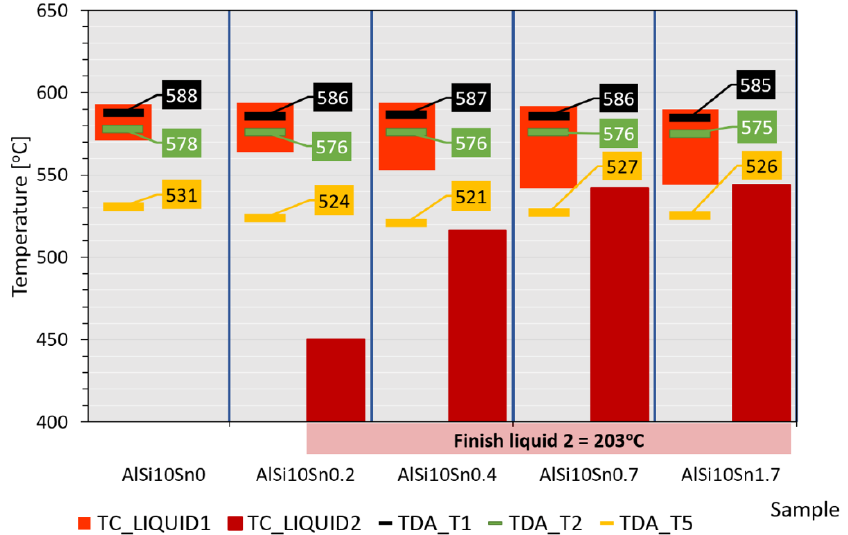
Figure 26. Schematic representation of crystallisation process by TC modelling (characteristic points of TDA marked). of TDA